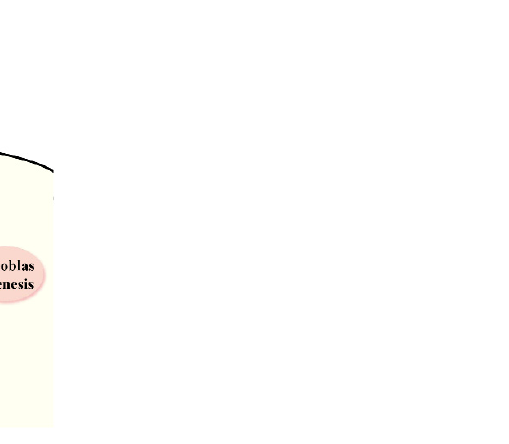
Figure 7. Mechanism of RES promoting osteogenic differentiation through ROS/HIF pathway. Schematic presentation of the role of RES on high-altitude hypoxia-induced osteoporosis via suppressing ROS/HIF-1 α pathway. Under the condition of hypoxia, the release of ROS was enhanced, leading to reduced level of PHD2 and increased level of HIF-1 α , which contributes to low expression of RUNX2 and deteriorative osteoblastogenesis. RES could effectively suppress the accumulation of ROS, thus rescuing the activity of PHD2, which leads to the downward level of HIF-1 α and upward expression of RUNX2 and osteoblastogenesis.